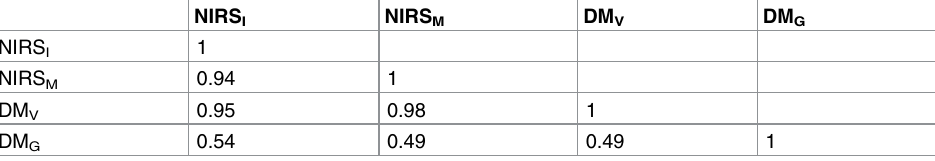
Table 9. Correlations among the different DMC